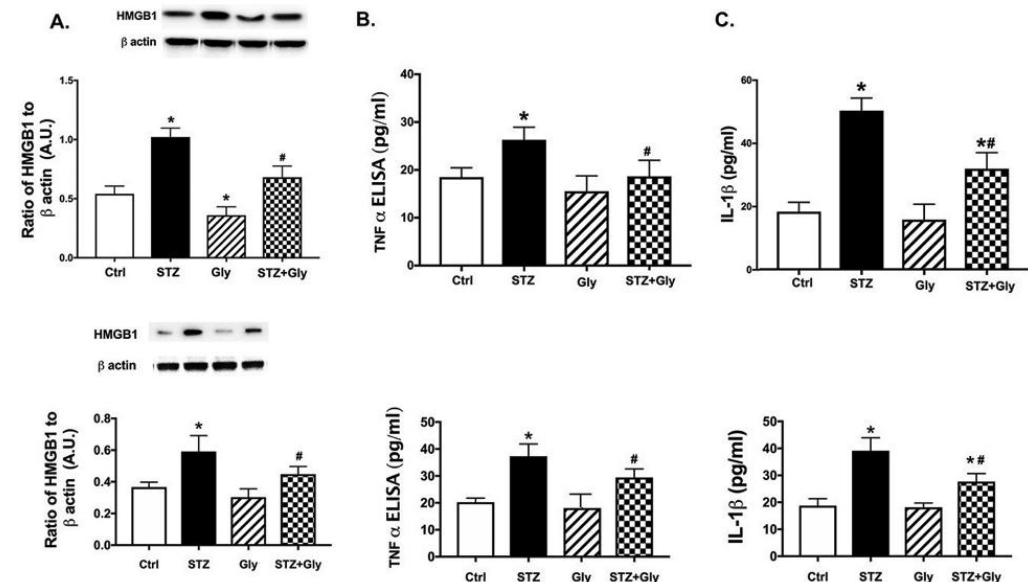
Figure 5. Inflammatory mediators are increased in diabetes. Top panels are at two months and bottom panels are at six months of diabetes. ( A ) represents high mobility group box 1 (HMGB1), ( B ) is tumor necrosis factor alpha (TNF α ), and ( C ) is interleukin-1-beta (IL1 β ) in control mice (Ctrl), control mice treated with glycyrrhizin (Gly), diabetic mice (STZ), and diabetic mice treated with glycyrrhizin (STZ + Gly). * p < 0.05 vs. ctrl, # p < 0.05 vs. Diabetes. n = 5 for each group.